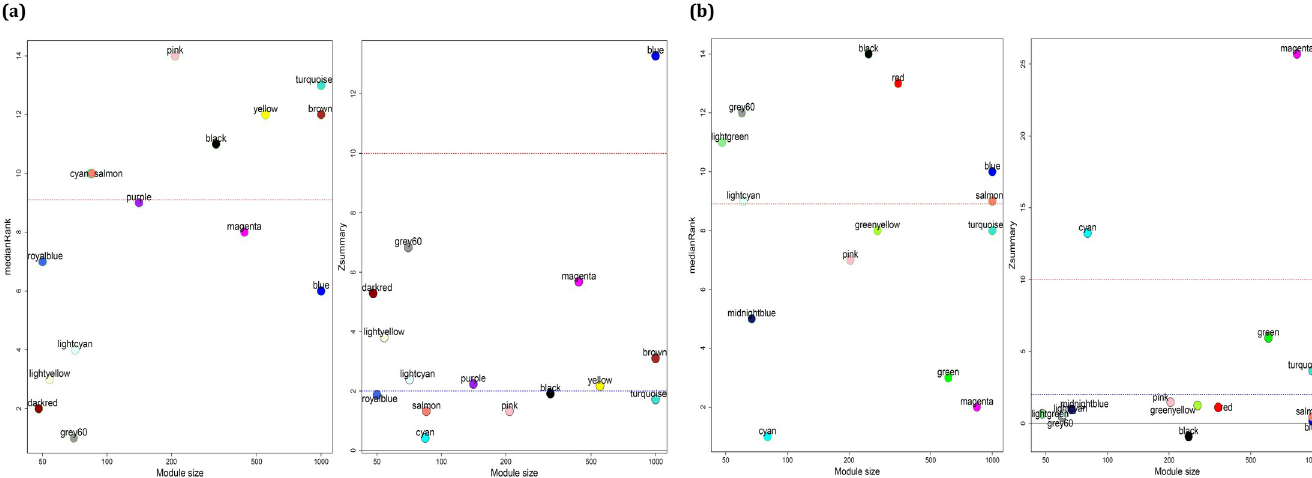
Fig 4. The medianRank and Z summary preservations plots against module size for determining preserved modules of (a) HAM/TSP and (b) ATLL modules in ATLL and HAM/TSP datasets, respectively. Modules with a medianRank > 9 and Z summary < 2 were considered as non-preserved modules.